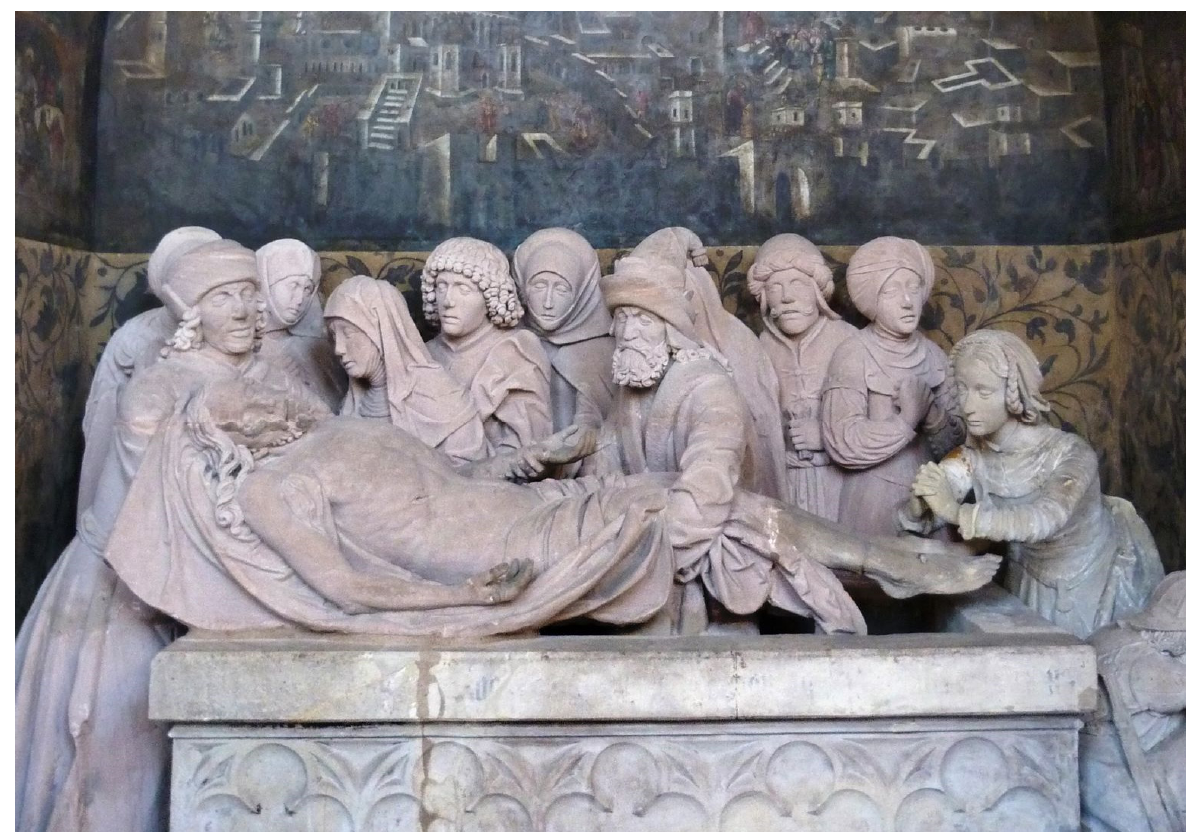
Figure 11. Kraft, Entombment from Stations of the Cross (Nuremberg, St. John’s Cemetery, Holzschuher Chapel), 1508.